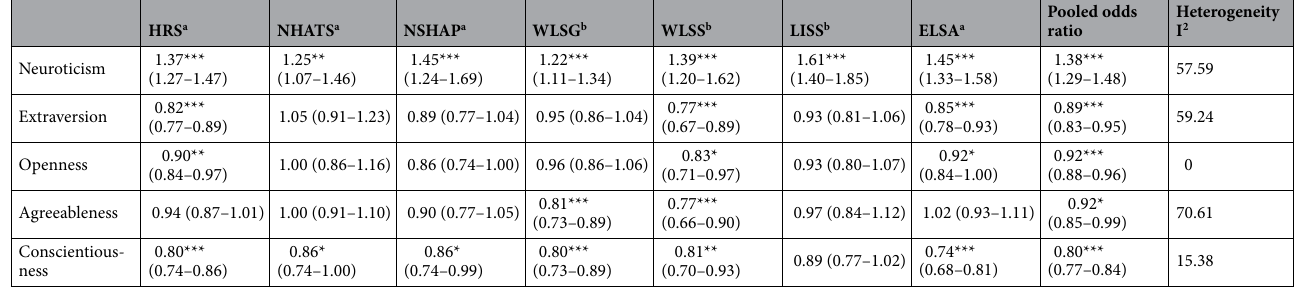
Table 3. Summary of logistic regression analysis predicting incident fatigue from baseline personality traits. Note. HRS: N = 4630; NHATS: N = 749; NSHAP: N = 778; WLSG: N = 1739; WLSS: N = 796; LISS: N = 1359; ELSA: N = 3952. a Adjusted for age, sex, education, and race. b Adjusted for age, sex, and education. * p < 0.05, ** p < 0.01, *** p <